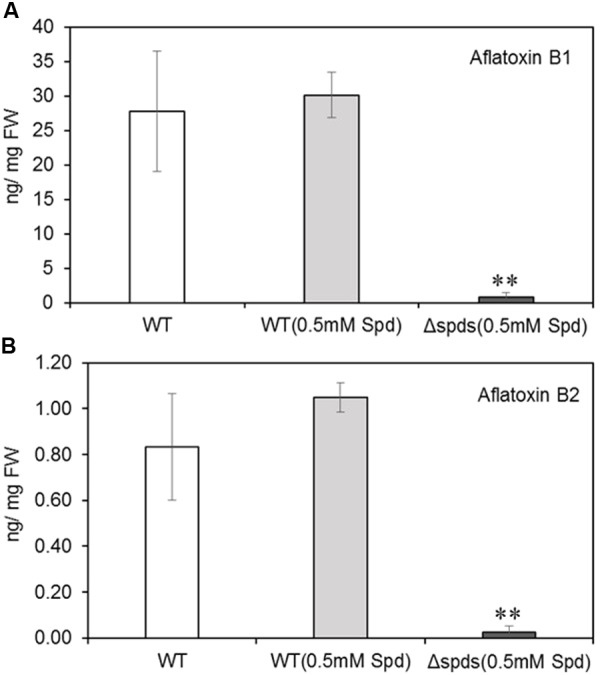
Aflatoxin contents in maize kernels infected with WT and Δspds A. flavus CA14 strains. (A) Aflatoxin B1; and (B) Aflatoxin B2. Data are Mean ± SE of four replicates, each replicate consists of 4–5 seeds (∗∗P ≤ 0.05 between WT and treatment, Student’s t-test).